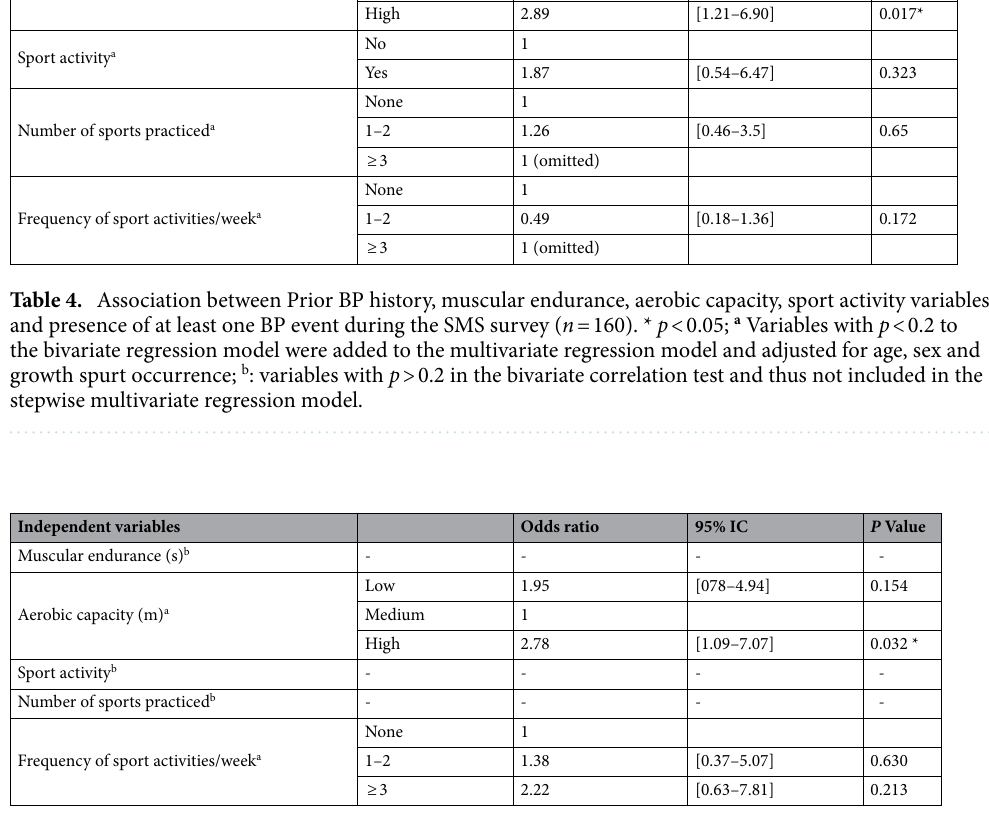
Table 5. Association between muscular endurance, aerobic capacity, sport activity variables and first BP episode incidence during the SMS survey (i.e., only follow-up responders without BP at study onset, n = 128). * p < 0.05; a Variables with p < 0.2 to the bivariate regression model were added to the multivariate regression model and adjusted for age and sex; b : variables with p > 0.2 in the bivariate correlation test and thus not included in the stepwise multivariate regression